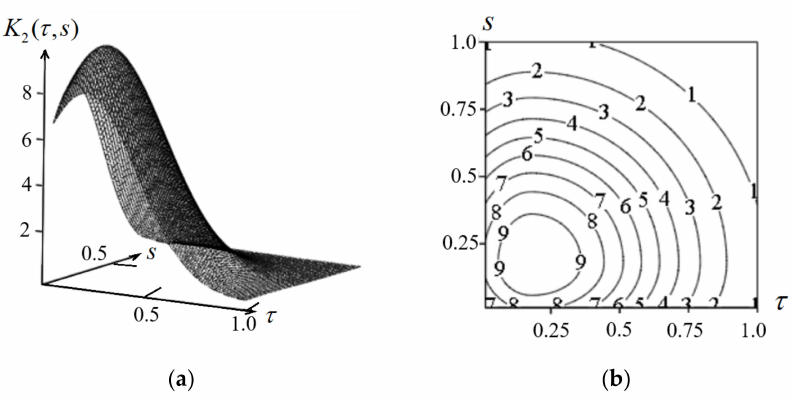
Figure 4. Test quadratic kernel: ( a ) the surface of K 2 ( τ , s ) ; ( b ) isolines.